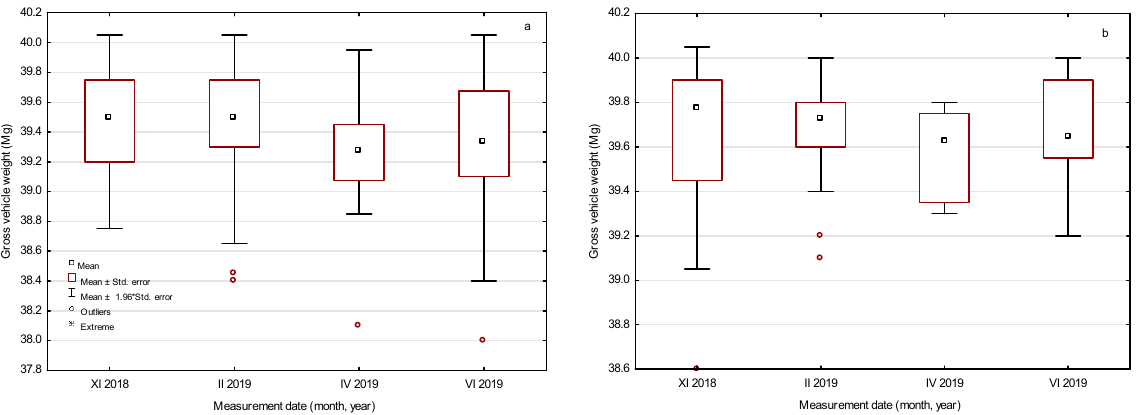
Figure 4. Comparison of gross vehicle weight (GVW) values by measurement date for unit A wood chips ( a ); sawdust ( b ).